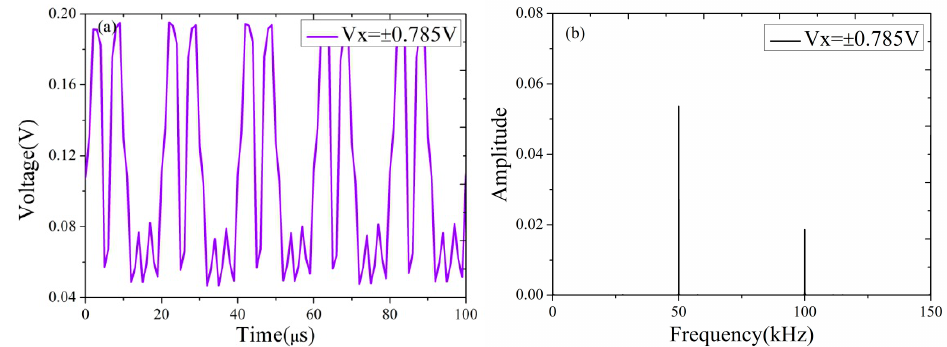
Figure 7. Output voltage of the sensor with a phase modulation of ∆ φ = π /2 in the experiments. ( a ) Output voltage waveform; ( b ) Corresponding frequency spectrum.